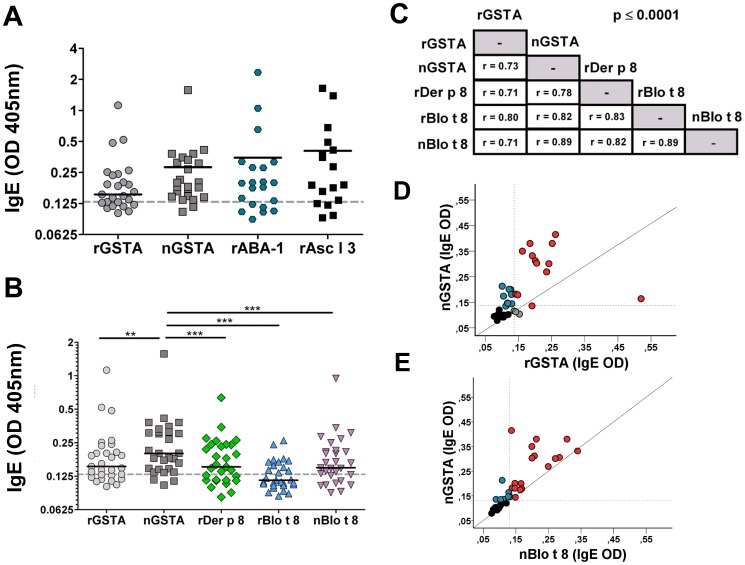
IgE reactivity of human sera to A. lumbricoides GST.(A) IgE levels to the natural Ascaris GST (nGSTA) and the recombinant Ascaris GST (rGSTA) in 29 subjects sensitized to the source (26 asthmatics and 3 non-asthmatic controls). The allergens rABA-1 and tropomyosin (rAsc l 3) are presented as positive control for the reactivity of these sera to other Ascaris allergens. (B) IgE levels to purified mite GSTs (rDer p 8, nBlo t 8 and rBlo t 8) in sera from 29 individuals sensitized to Ascaris. Each dot indicates an individual serum. ** p<0.001, *** p<0.0001. The dotted line indicates the cut-off value for positivity to GSTs (OD405≥0.13). Solid bar indicate median. (C) Correlation between specific IgE levels to Ascaris and mite GSTs (n = 36); r =  Spearman coefficient. (D) Correlation of specific IgE levels between the nGSTA and the rGSTA. (E) Correlation of specific IgE levels between the nGSTA and nBlo t 8. For figures D and E, red dots indicate individuals with dual-sensitization; blue dots indicate individuals mono-sensitized to nGSTA and black dots non-sensitized subjects.